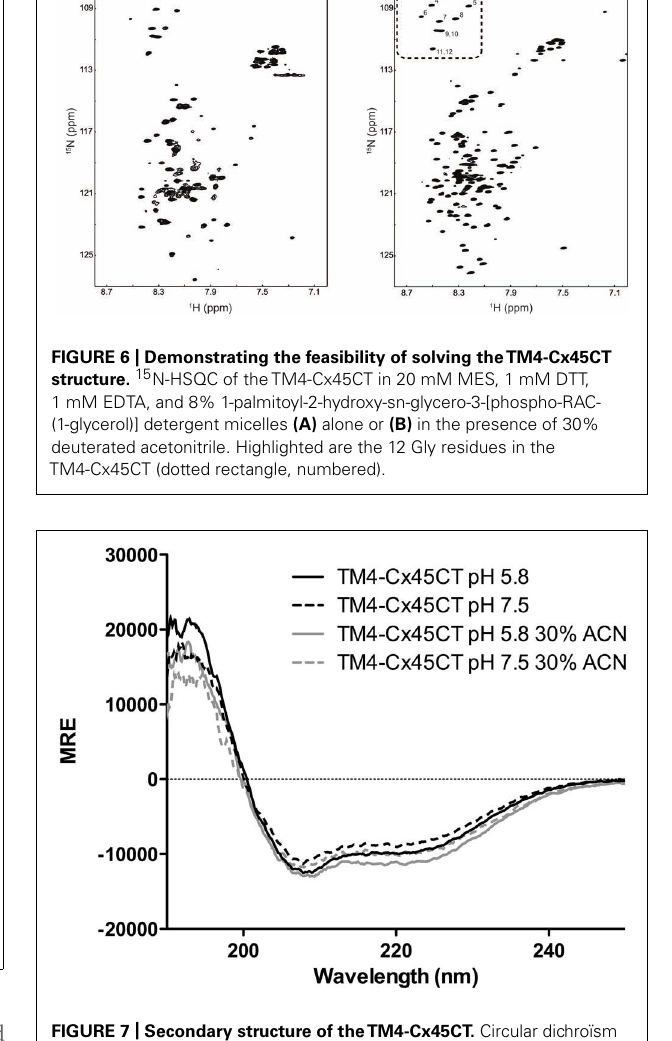
FIGURE 7 | Secondary structure of theTM4-Cx45CT. Circular dichroïsm of theTM4-Cx45CT in 20 mM MES, 1 mM DTT, 1 mM EDTA, and 8% 1-palmitoyl-2-hydroxy-sn-glycero-3-[phospho-RAC-(1-glycerol)] detergent micelles alone (black) or in presence of 30% acetonitrile (gray) at pH 7.5 (solid lines) and 5.8 (dashed